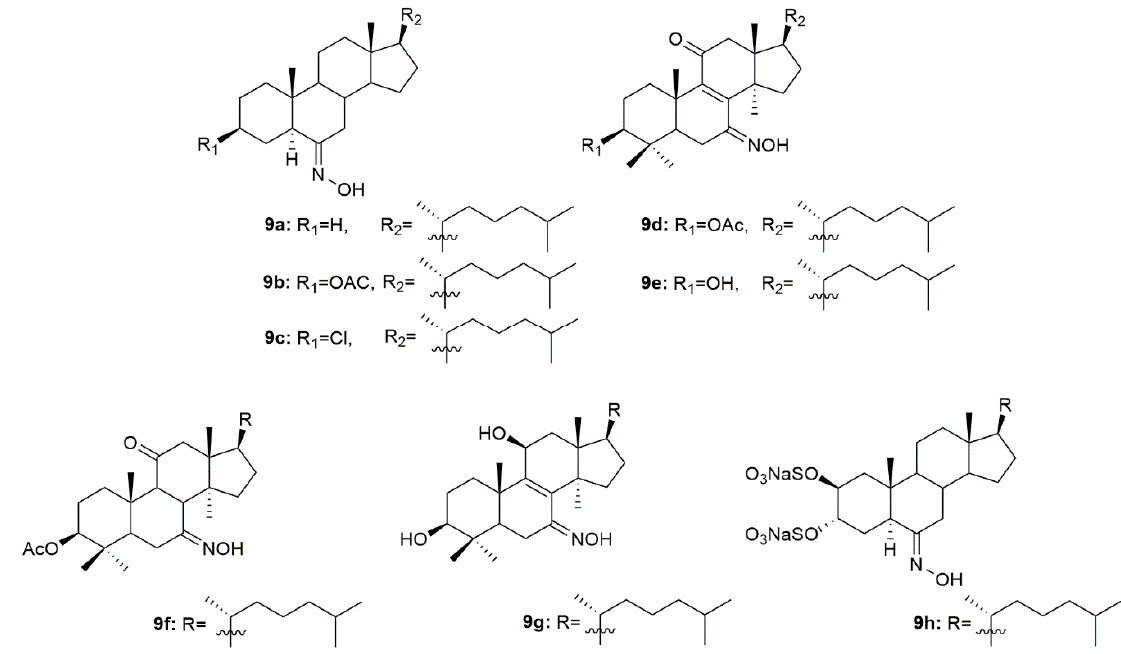
Figure 12. Cholestane oxime derivatives with antimicrobial activity.